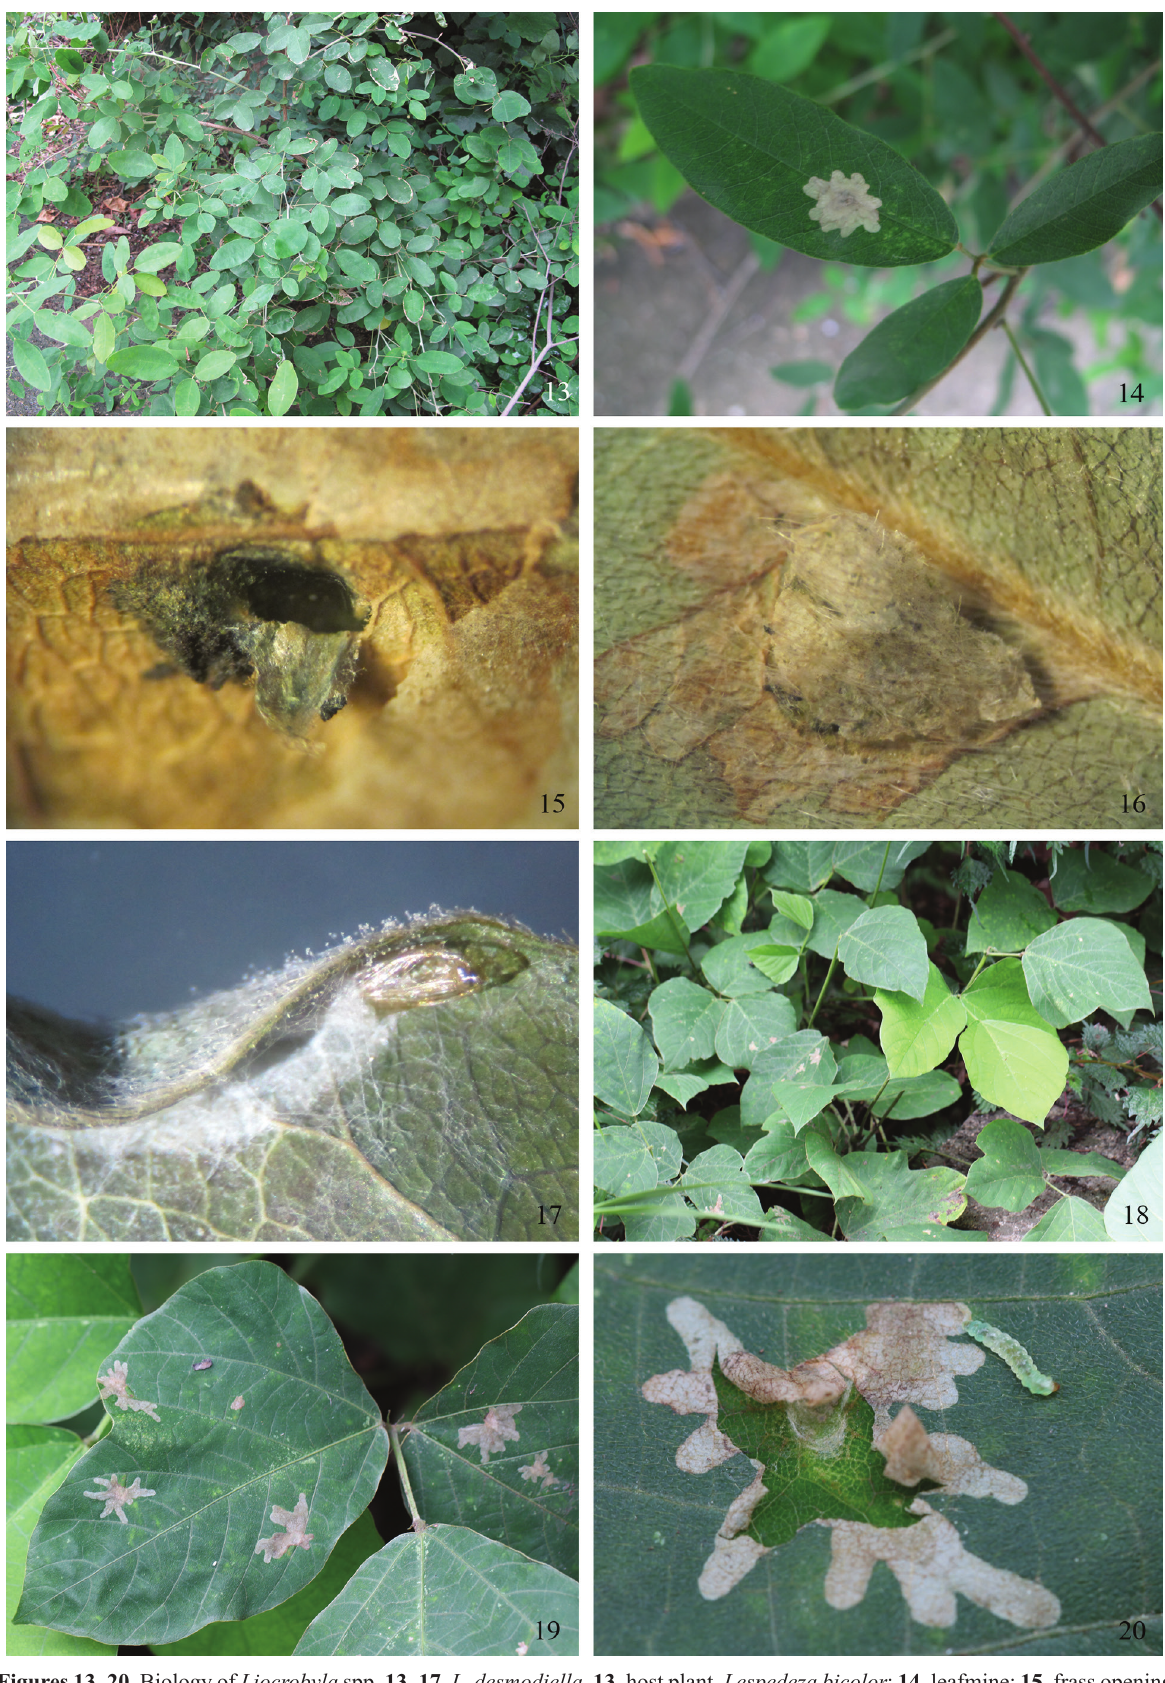
Figures 13–20. Biology of Liocrobyla spp. 13–17. L. desmodiella , 13. host plant, Lespedeza bicolor ; 14. leafmine; 15. frass opening on upper side of leaf; 16. frass opening on lower side of leaf; 17. cocoon and pupal exuviae; 18–20 . L. lobata , 18. host plant, Puer- aria montana var. lobata ; 19. leafmines; 20. an opened mine with a larva